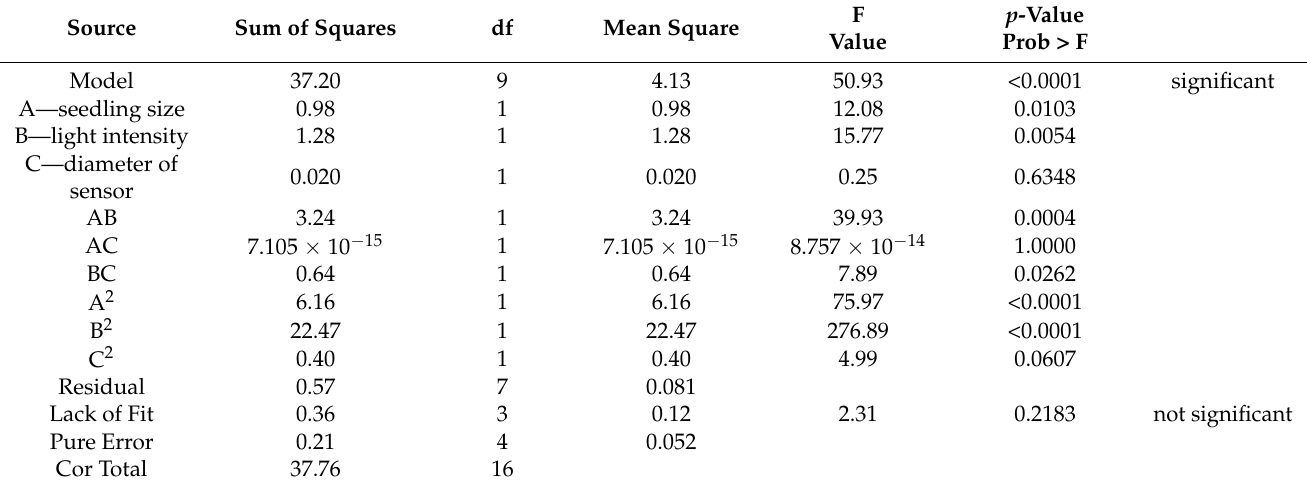
Table 3. Analysis of variance for the subdivision air separation